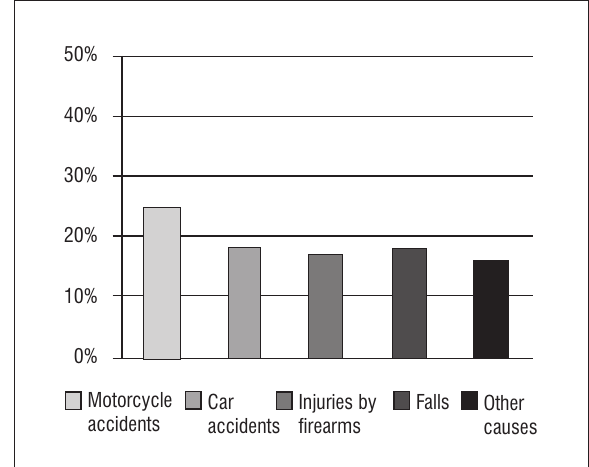
Figure 1 - Main causes of spinal cord injuries